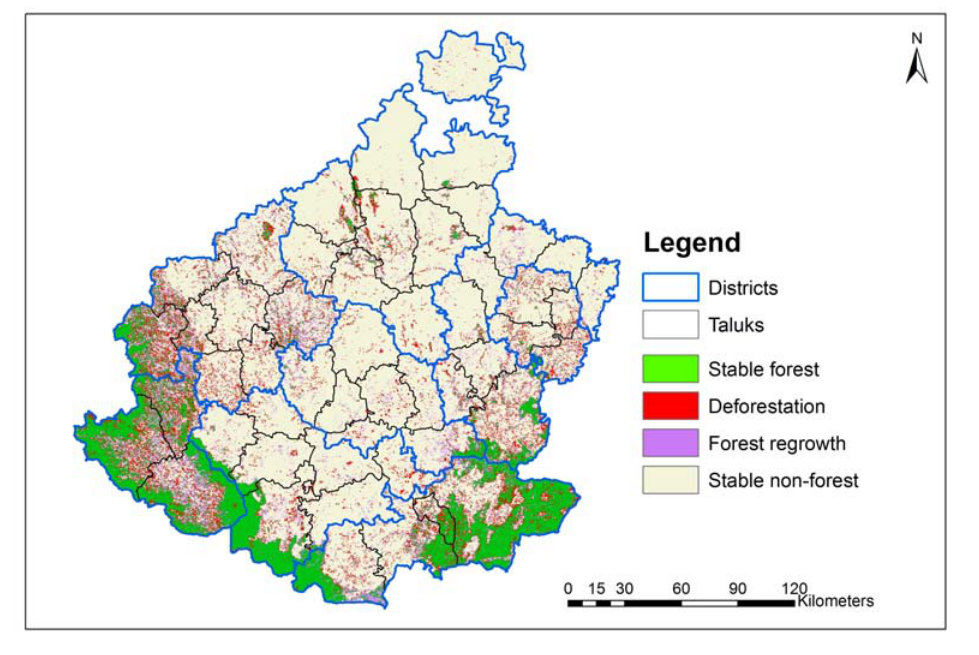
Figure 4. Map of forest change trajectories between